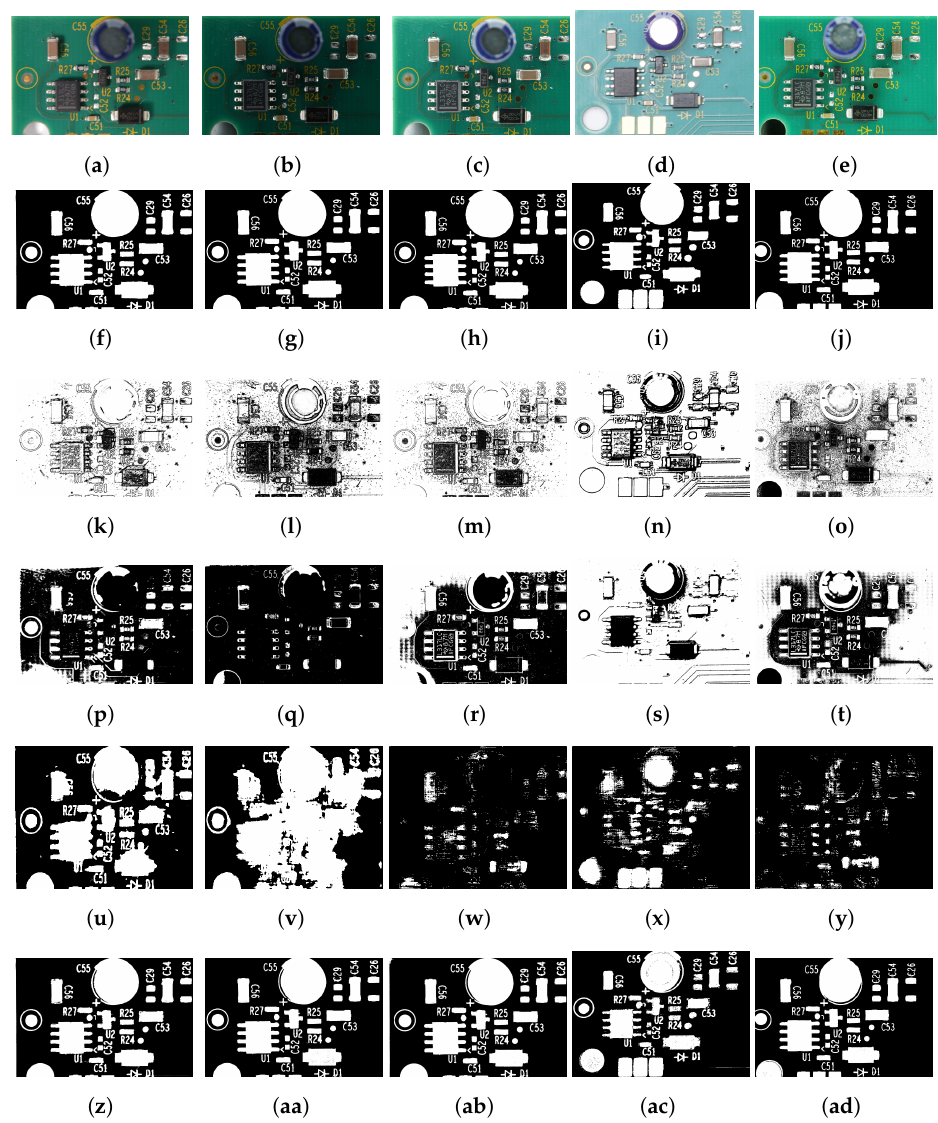
Figure 8. ( a – e ) Sample images of the PCA board dataset with varying image intensity and ( f – j ) corresponding ground truth. ( k – o ) Results using Singh et al. [38], ( p – t ) DTP-Net